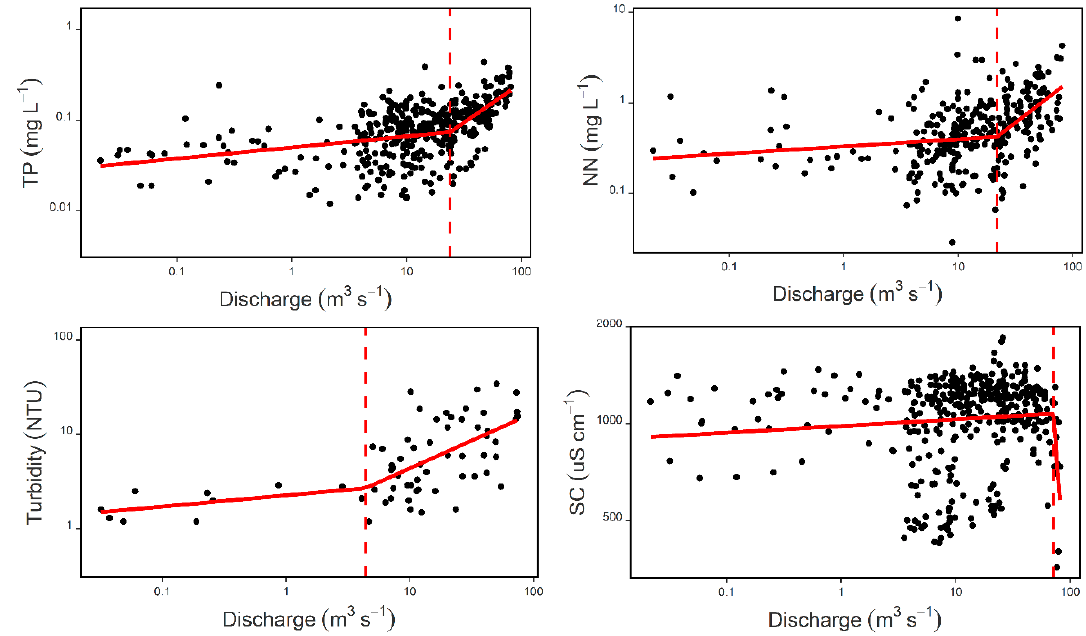
Figure 6. Concentration–discharge ( C–Q ) relationship plots for water quality constituents with discharge thresholds at HC6.